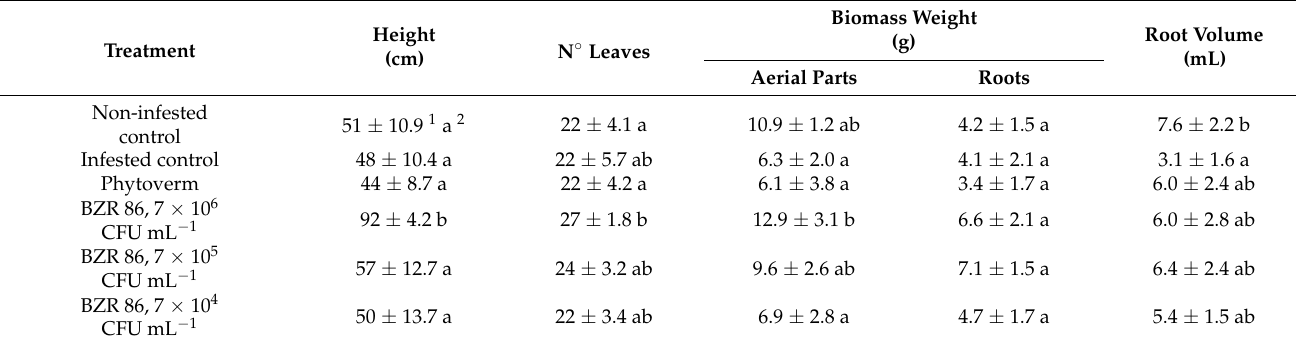
Table 5. The influence of Bacillus velezensis BZR86 on the growth and development of cucumber plants (cv.